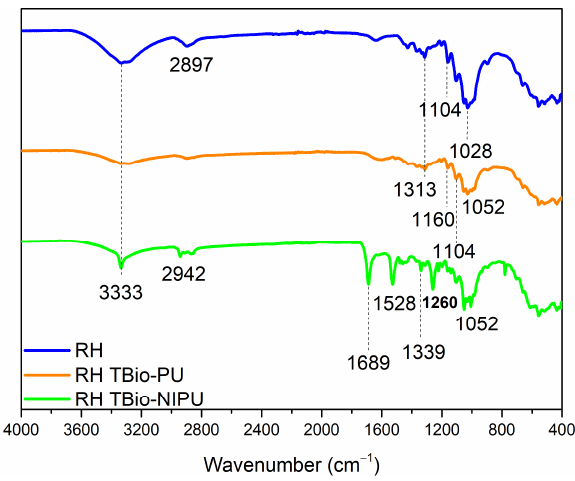
Figure 9. FTIR spectra of impregnated H 2 O 2 pre-treated ramie fibers.